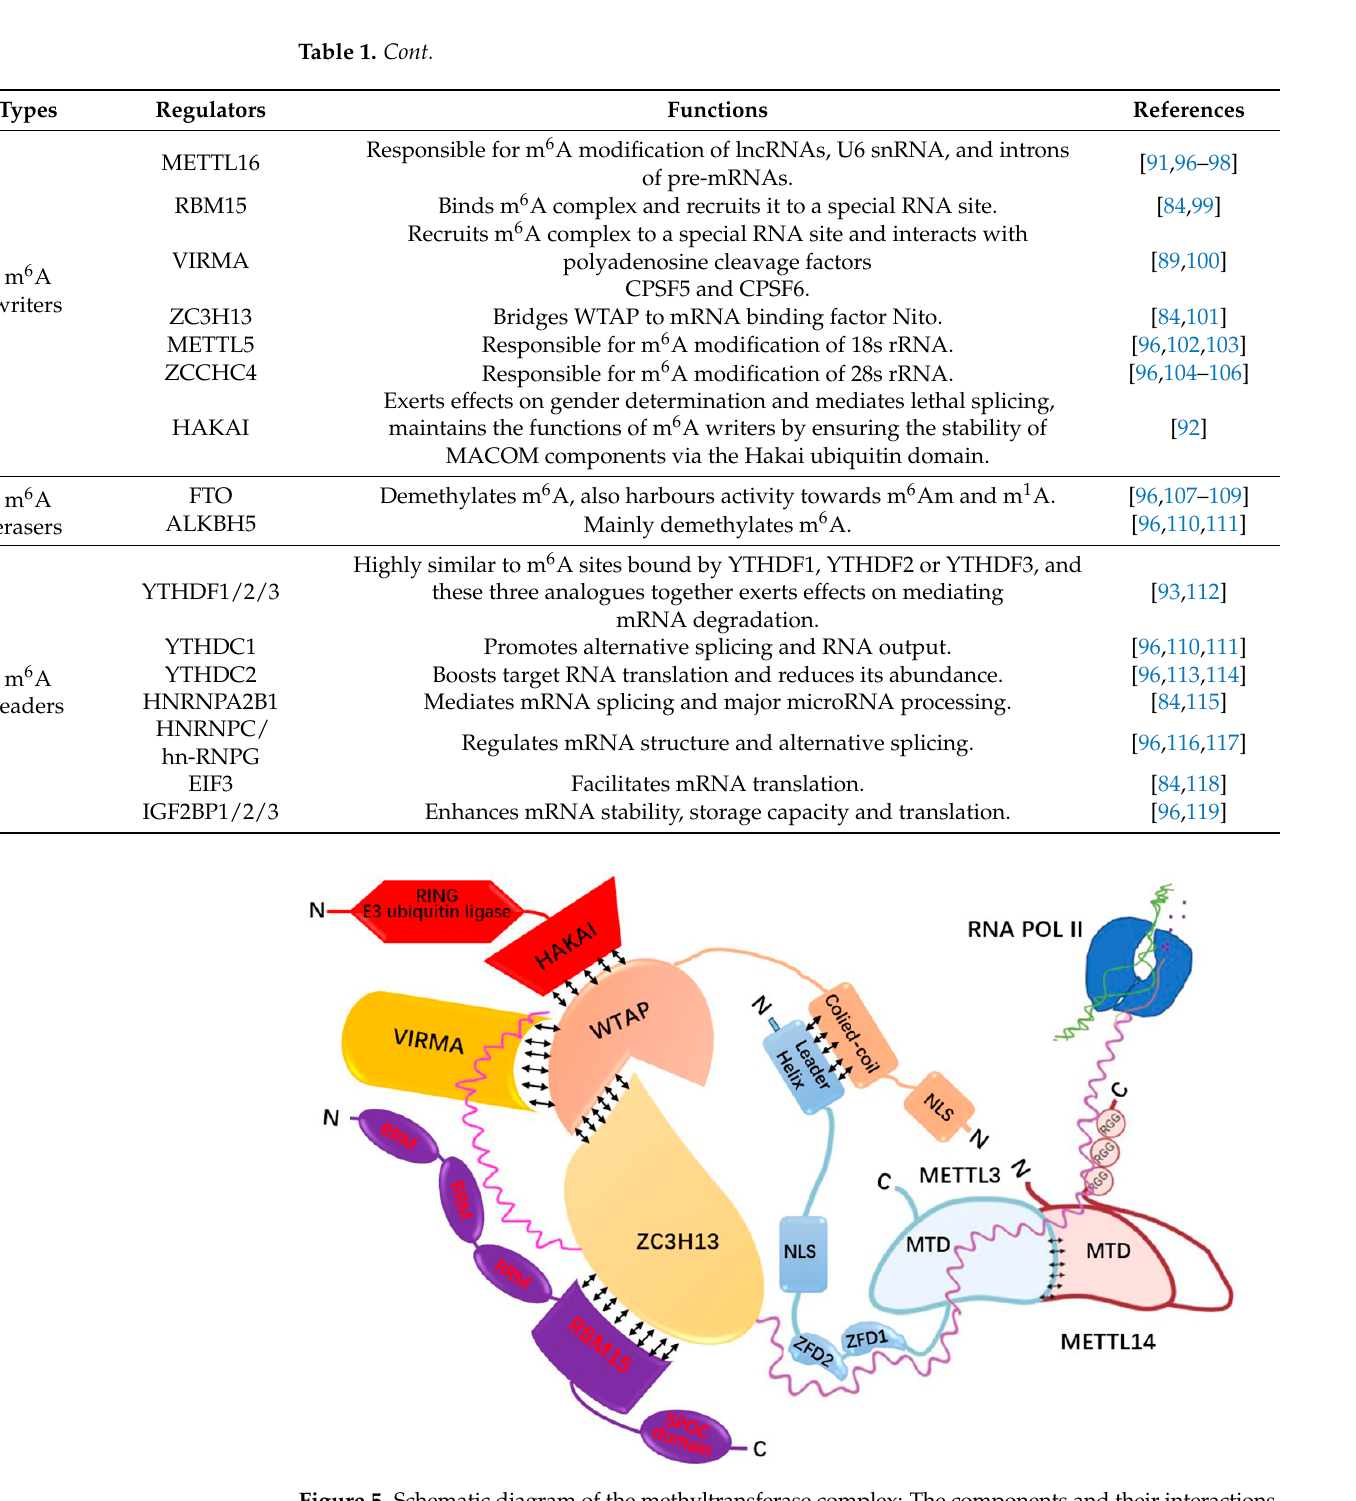
Figure 5. Schematic diagram of the methyltransferase complex: The components and their interac- tions. Table 1. M 6 A related genes and their basic functions.